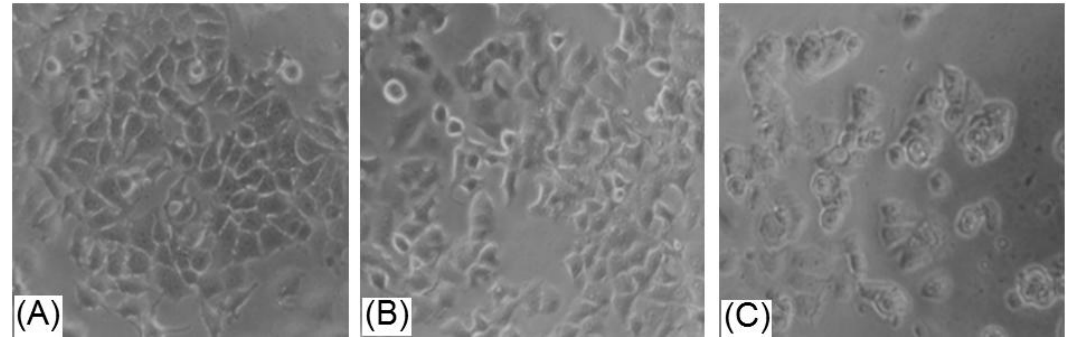
Figure 2. Effect of MPE and tamoxifen on MCF-7 morphology after 24h incubation (A) Untreated cells (B) 40µg/mL MPE treated cells (C) 10-6µg/mL tamoxifen treated